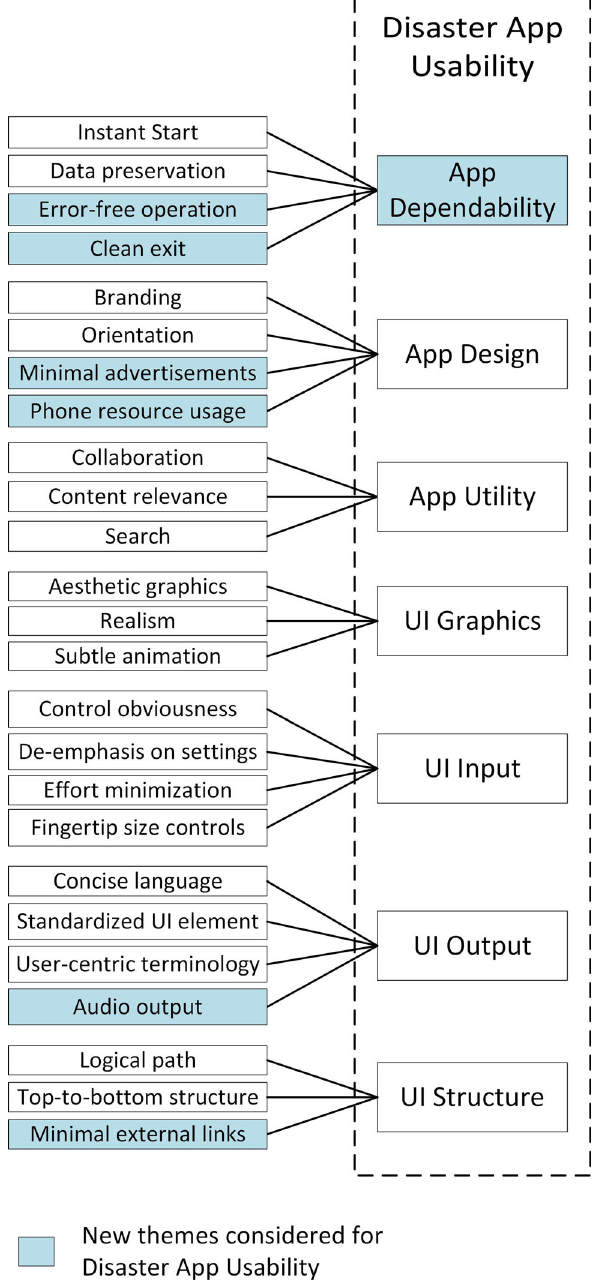
Fig. 4 Conceptual framework for disaster app